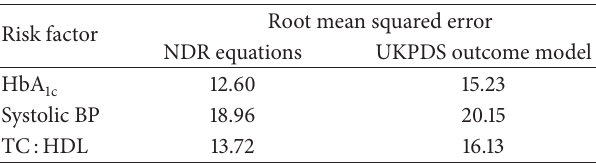
Table 4: Root mean squared error of the regression of observed on predicted values in nonsmoker